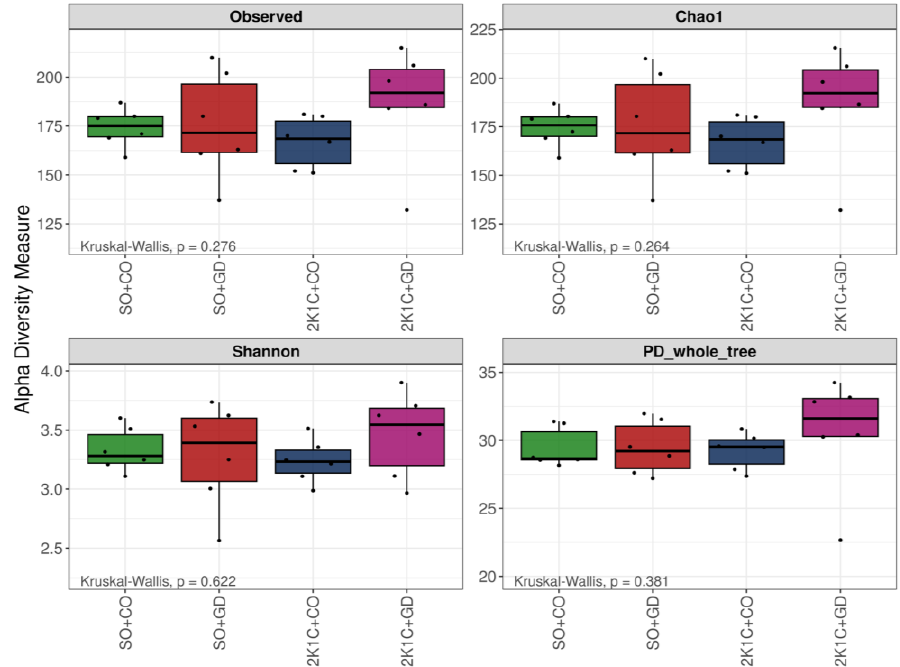
Figure 4. Box plots of the alpha diversity (observed number of ASVs, Chao1, Shannon and the PD whole tree) of each sample group. Black dots represent the individual samples in each group. SO, sham operation; CO, corn oil; 2K1C, 2-kidneys-1 clip; GD, Garcinia dulcis flower extract.